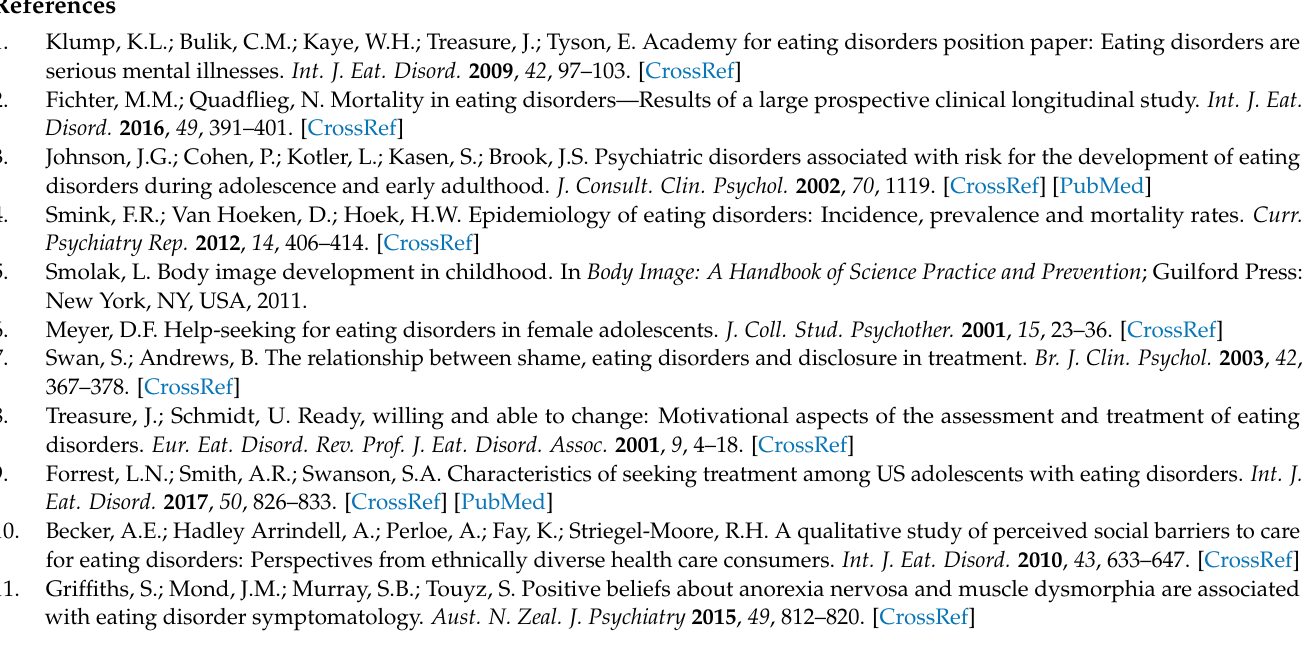
Features, Table S2: Discovery Group- Teen Motivations and Barriers for app engagement, Table S3: Social Media Use Among Those in Discovery and Testing